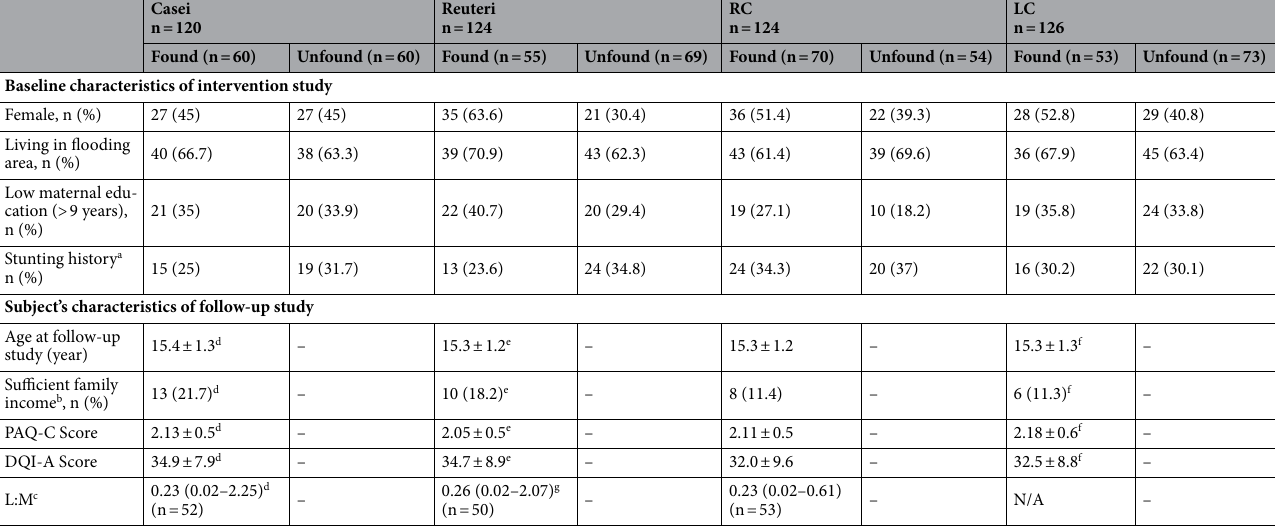
Table 1. Characteristics of adolescents according to assigned treatment. Values are mean ± SD, or median (min–max), or n (%). Unfound defined as subjects who moved, died, loss to follow-up and refused to participate in the follow-up study. DQI-A diet quality index-adolescent, L:M lactulose mannitol ratio, PAQ-C physical activity questionnaire-children. a Defined as a height-for-age Z-score < − 2 SDs before the